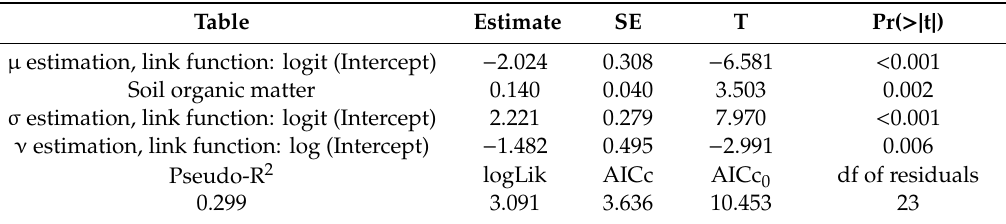
Table 4. Zero-inflated beta regression model of the proportion of severely damaged Fraxinus excelsior trees within sets of 15 sampled trees per study plot ( n = 27). Table µ estimation, link function: logit (Intercept)